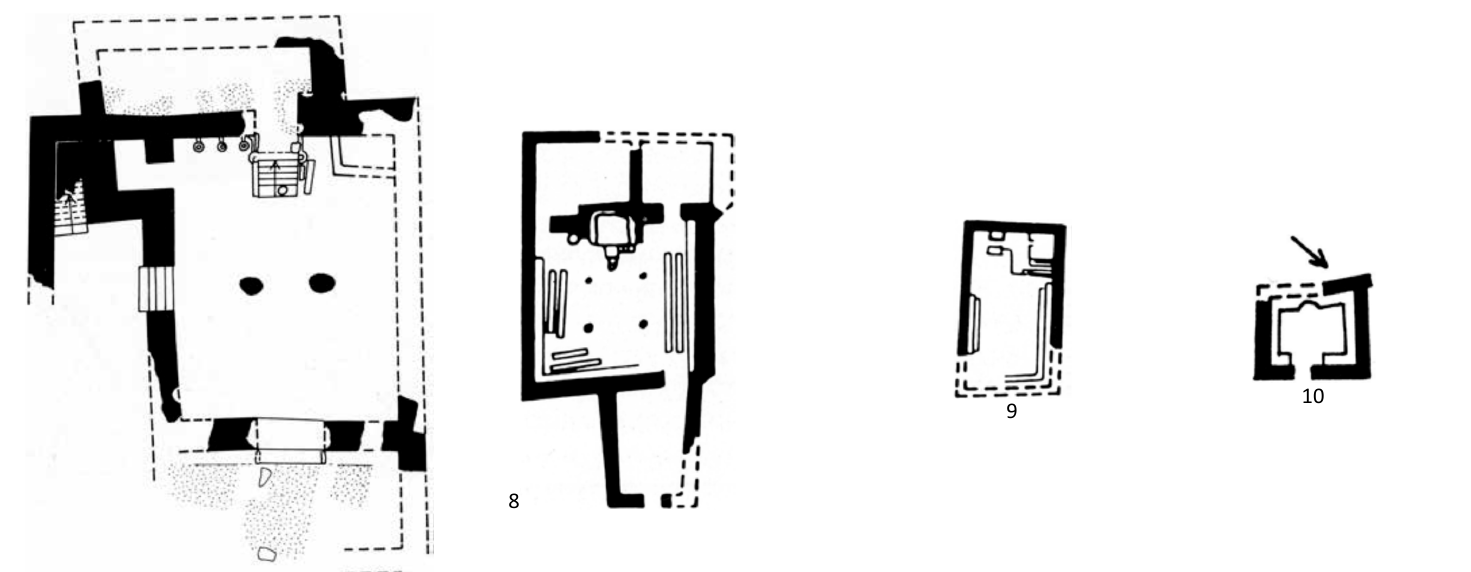
Figure 2. Plans of various Late Bronze Age Canaanite temples mentioned in the text (After Bunimovitz 2019: Figure 27. Originally published in Mazar 1992b; Courtesy of the Israel Exploration Society). 1. Megiddo str. VIII; 2. Shechem; 3. Hazor, “Northern Temple”, Area A in the upper city; 4. Hazor, Area H in the lower city, str. 3; 5. Hazor, Area H in the lower city, str. 1A; 6. Beth Shean, str. VI; 7. Lachish, “Acropolis Temple”, str. VI; 8. Lachish, Fosse Temple III; 9. Tel Mevorakh; 10. Hazor, Stele Temple, Area C in the lower city.